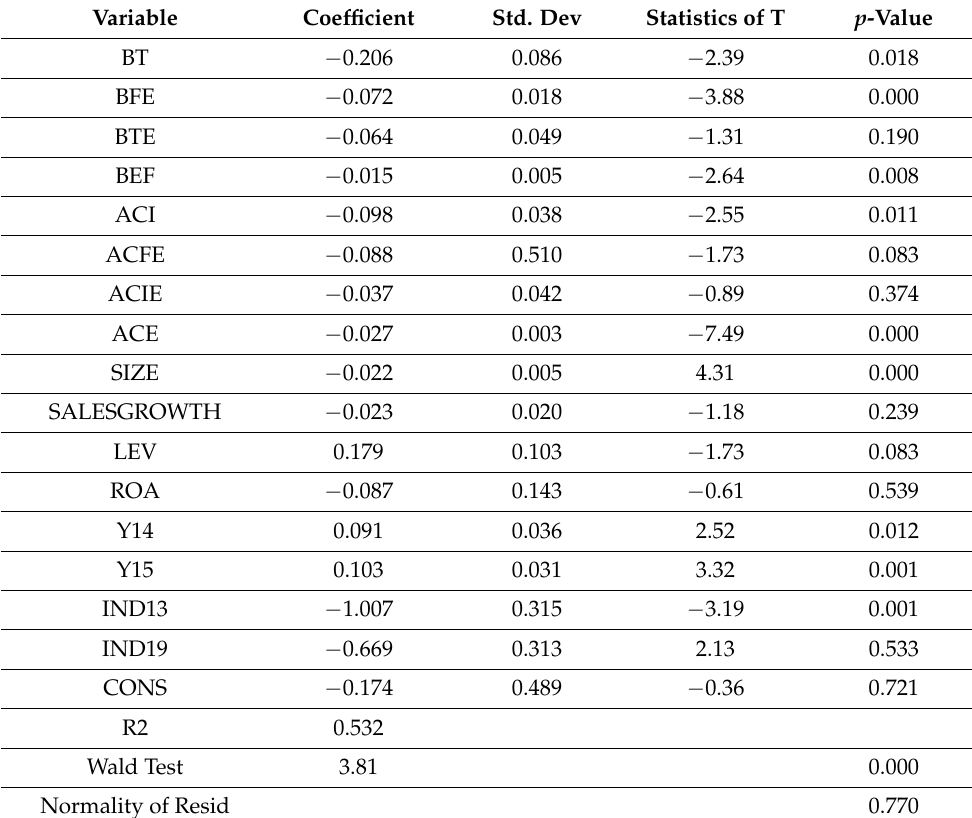
Table 17. The results of estimation of the second model by the method of fixed